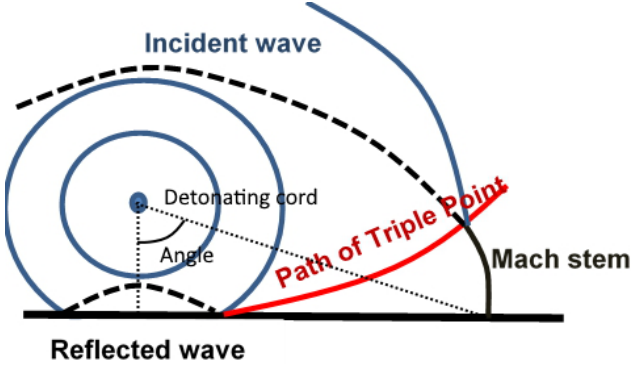
Figure 11. Sketch of Mach stem and triple point emergence and behaviour.